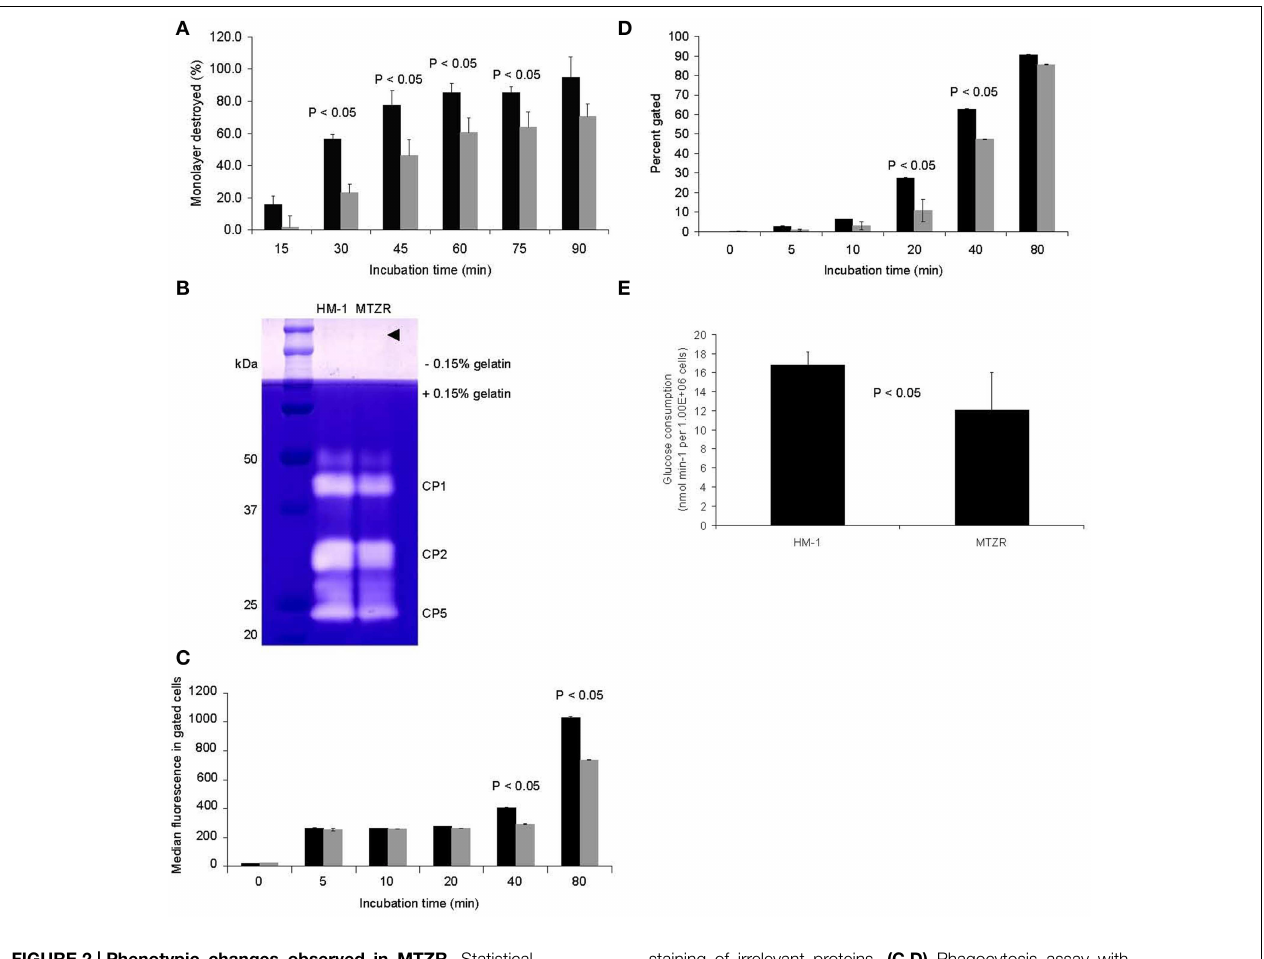
FIGURE 2 | Phenotypic changes observed in MTZR. Statistical significance is indicated ( P -value < 0.05). (A) CHO monolayer destruction assay of HM-1 (black bars) and MTZR (gray bars). (B) Zymography of whole cell lysates of HM-1 and MTZR. An arrowhead indicates comparable protein loading per lane as estimated by CBB